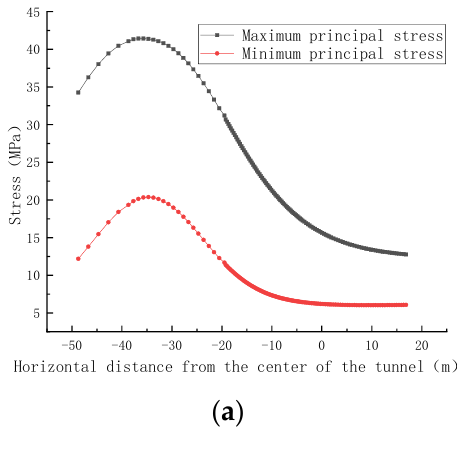
Figure 22. Changes in the principal stresses of the roadway’s surrounding rock when the coal column is 15 m. ( a ) Horizontal direction. ( b ) Variation direction.